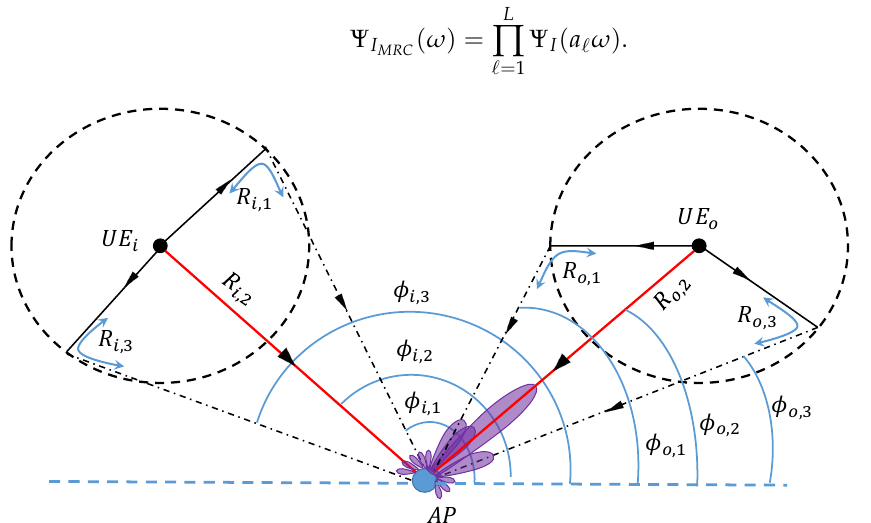
Figure 14. NLOS model: every user has a few NLOS links in addition to an LOS link. LOS links are shown with thick red lines, and NLOS links are shown with dashed lines reflected back from the perimeter of a circle around the UE. Here, the UE o is the user of interest and and UE i is an interferer. + h 2 ) 1/2 , and R (cid:96) > 1 are affected by the The NLOS distances D (cid:96) = ( R 2 o , (cid:96) for o , (cid:96)